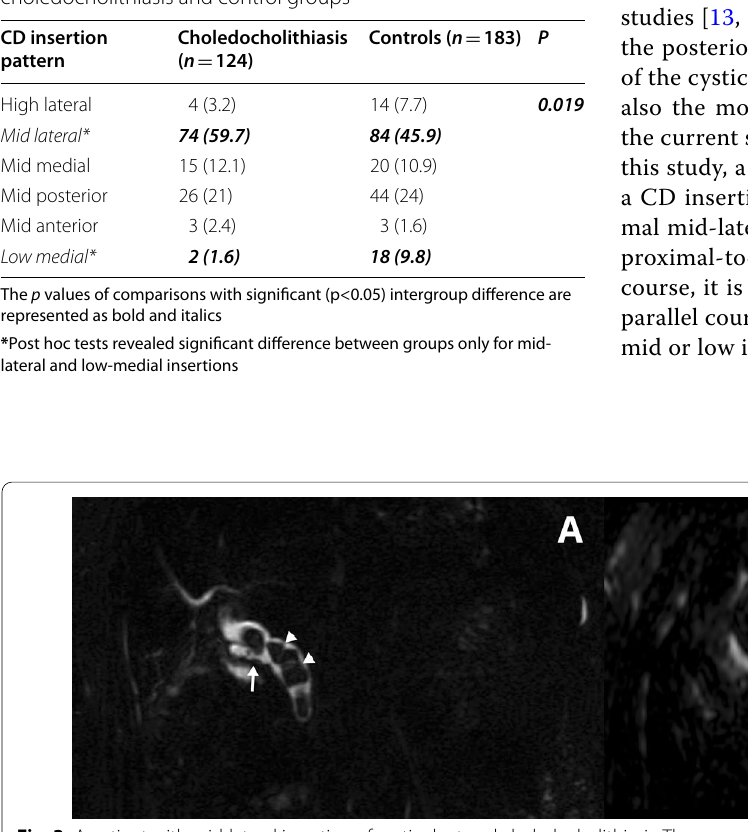
Table 4 Comparison of CD insertion patterns between choledocholithiasis and control groups